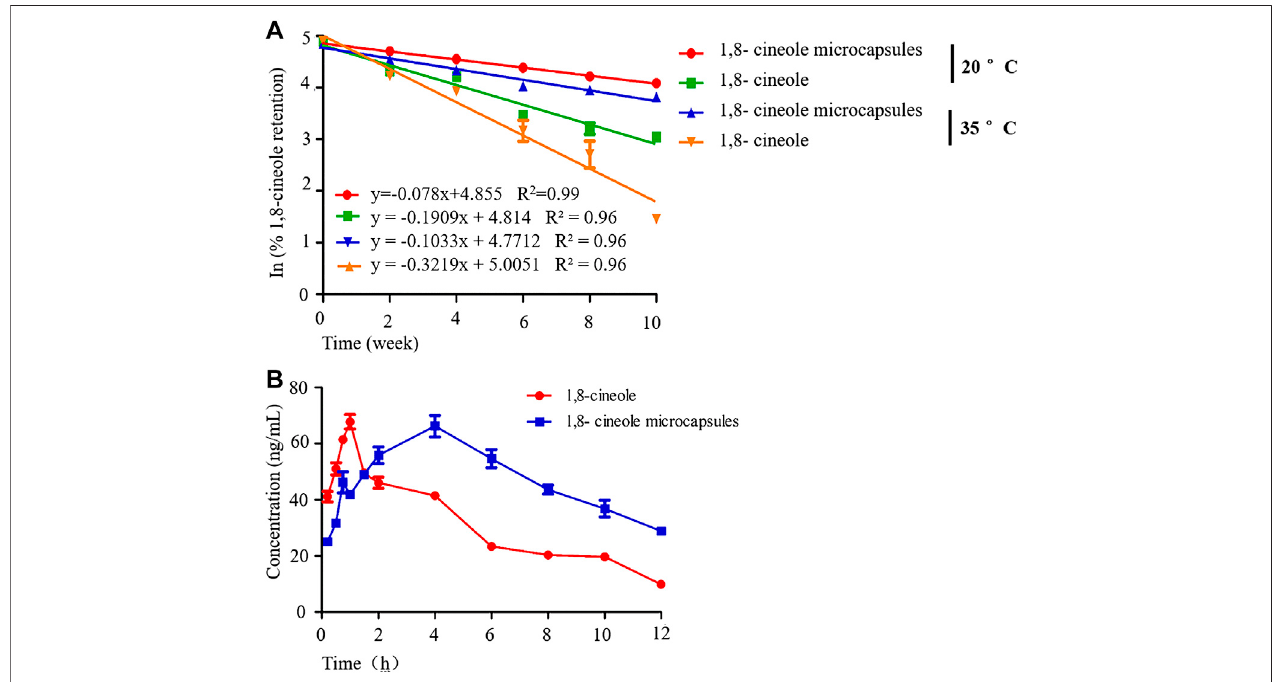
FIGURE2| Thestabilityandpharmacokineticsof1,8-cineolemicrocapsule.Notes: (A) thestabilityof1,8-cineolemicrocapsuleand1,8-cineoleat20and35 ° C; (B) the concentration of 1,8-cineole in plasma after 1,8-cineole microcapsule or 1,8-cineole treatment at the indicated times; n (cid:2) 5.